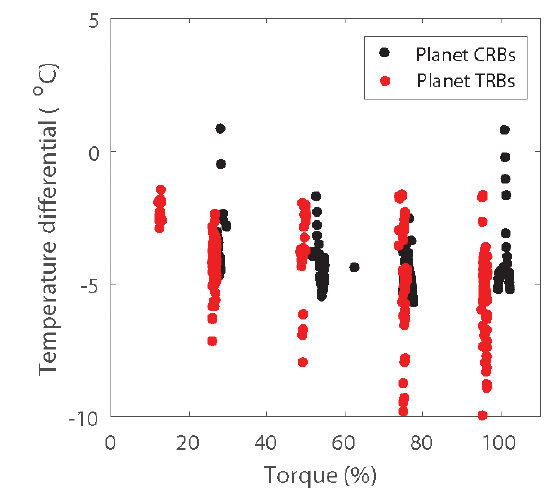
Figure 14. Differential between the gearbox sump temperature and the average of planet bearing inner-ring temperatures.